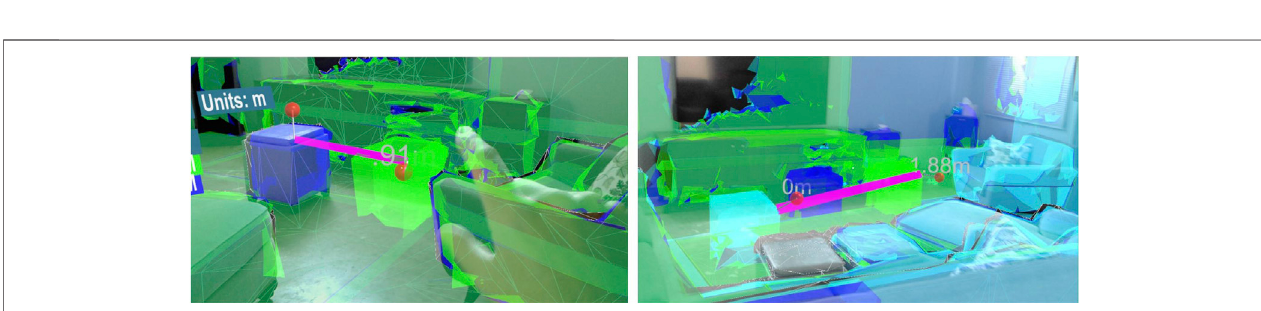
FIGURE 13 | AR application – Time Machine Measure. (A) TMM measurement from Position-1 to Position-2. (B) TMM measurement from Position-1 to Position-3.